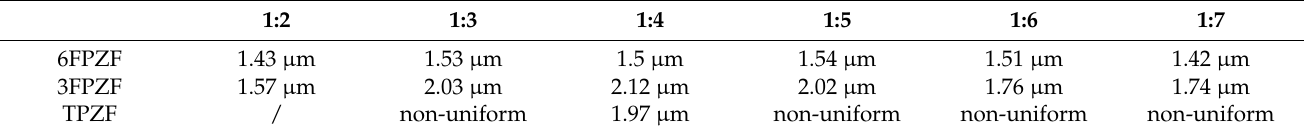
Table 1. Particle sizes of 6FPZF, 3FPZF and TPZF microspheres with varying molar ratios.